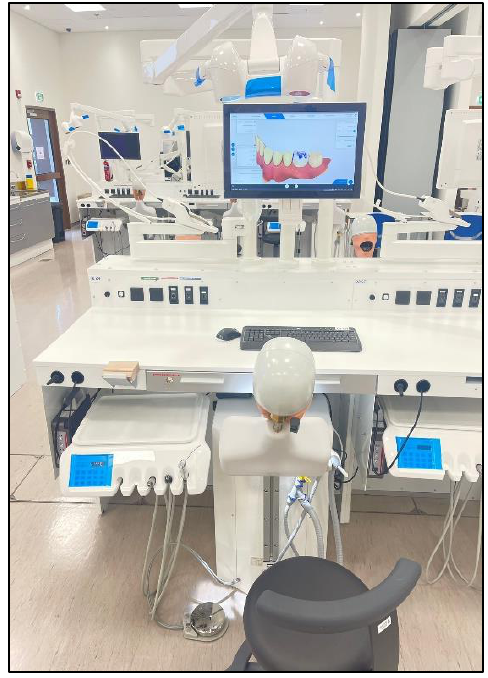
Figure 2. Conventional Mannequin